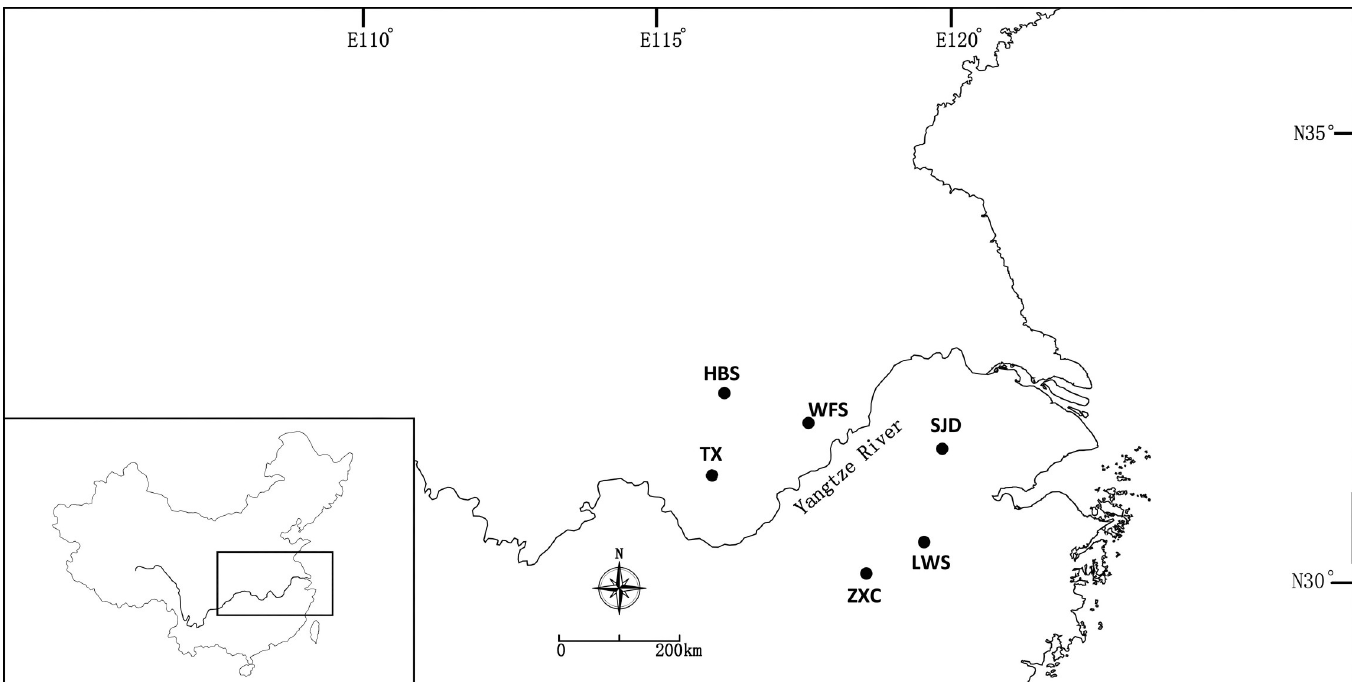
Fig 1. The distribution range of six natural populations of Parrotia subaequalis in